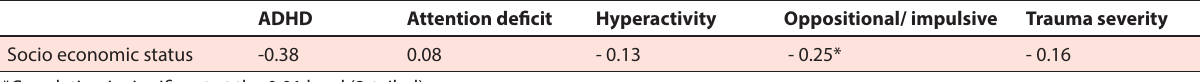
Table 6. Correlation matrix between trauma severity, ADHD, attention deficit, hyperactivity, and oppositional/impulsive components with economical and social situations